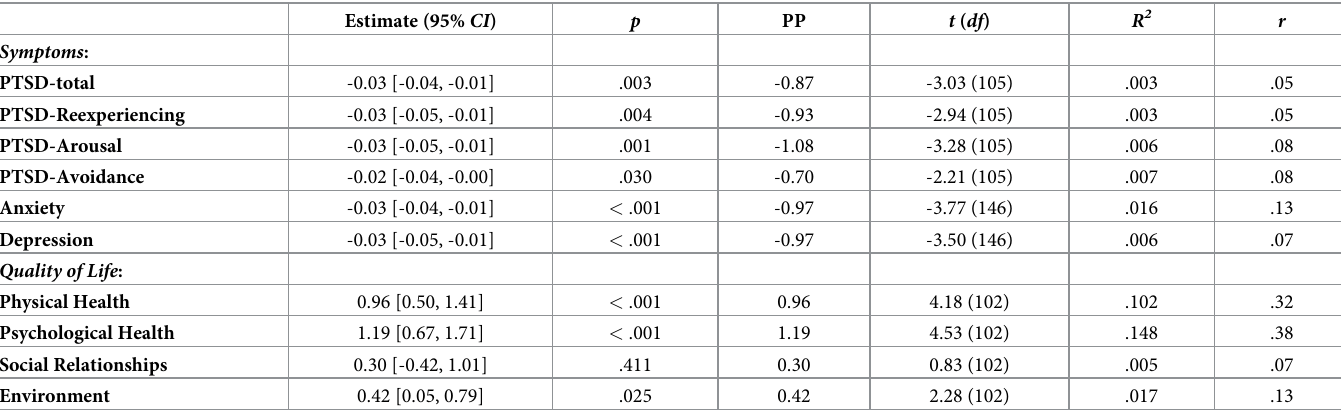
Table 2. Changes in symptoms and quality of life over the 10-year follow-up.